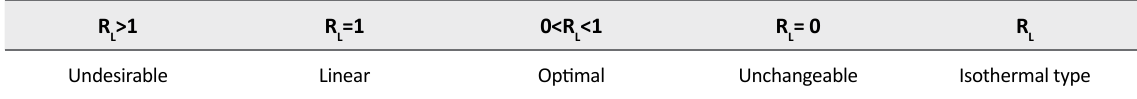
Table 2. Different values of RL balance parameter [12]